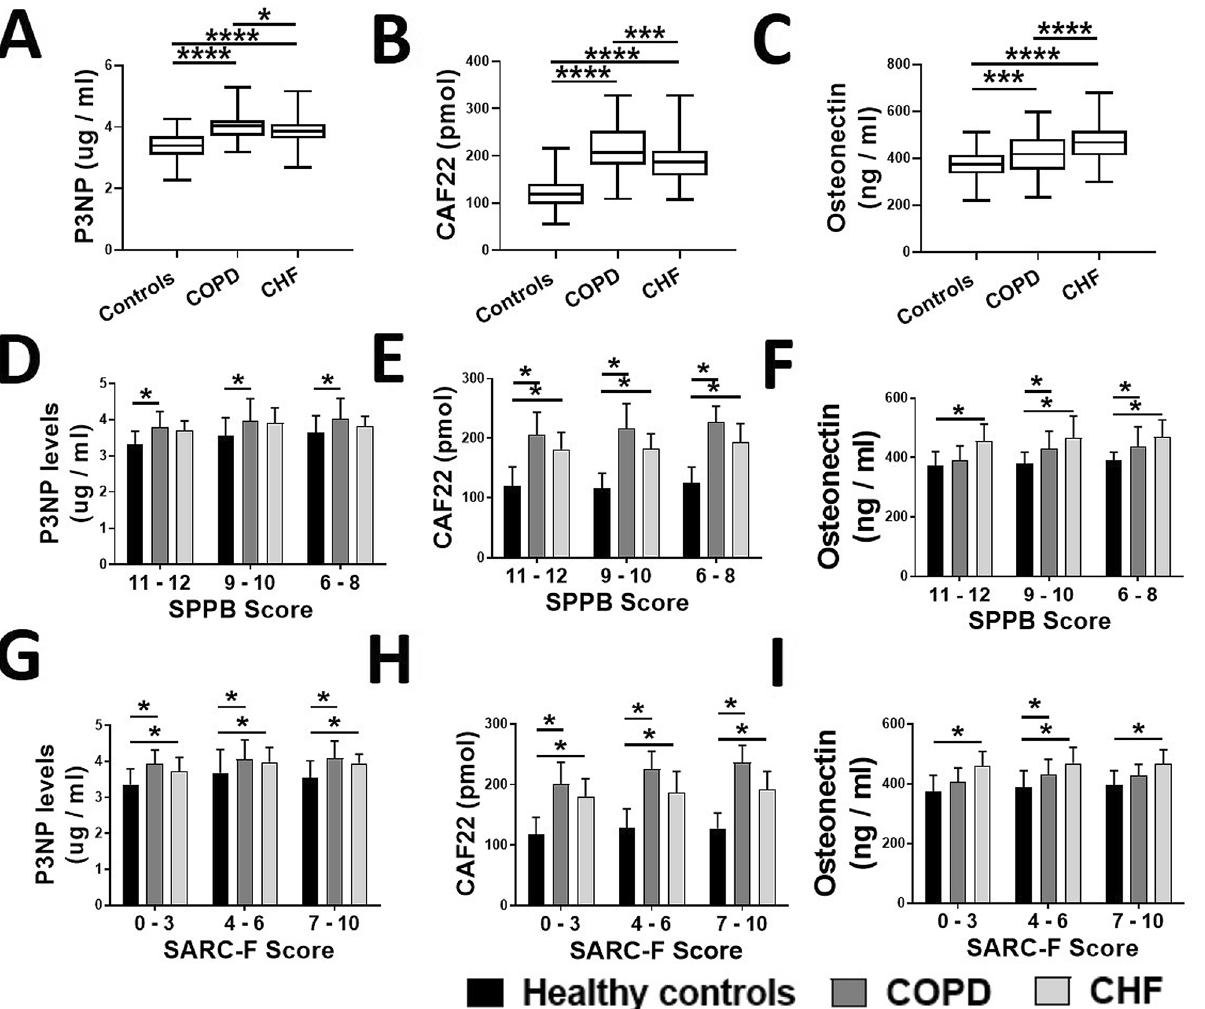
Figure 2. Comparison of circulating P3NP ( A ), CAF22 ( B ) and osteonectin ( C ) levels in healthy controls (N = 87) and patients with COPD (N = 86) and CHF (N = 81). The biomarkers levels were generally higher in the participants with advanced sarcopenia based on SPPB ( D , E , and F ) and SARC-F ( G , H , and I ) scoring. Values are expressed as mean ± SD, one-way analysis of variance. * p <